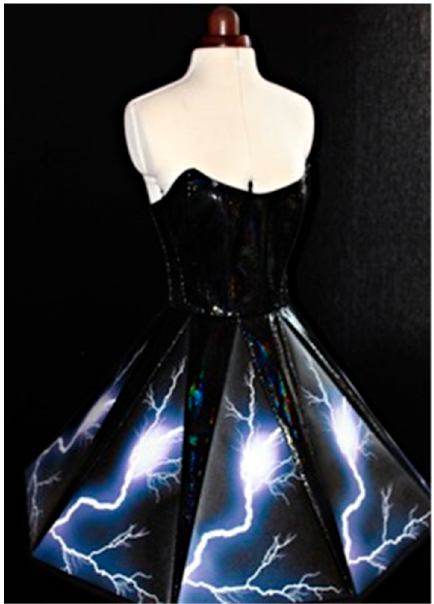
Figure 8. “Thunderstorm dress” for Eye of the Storm